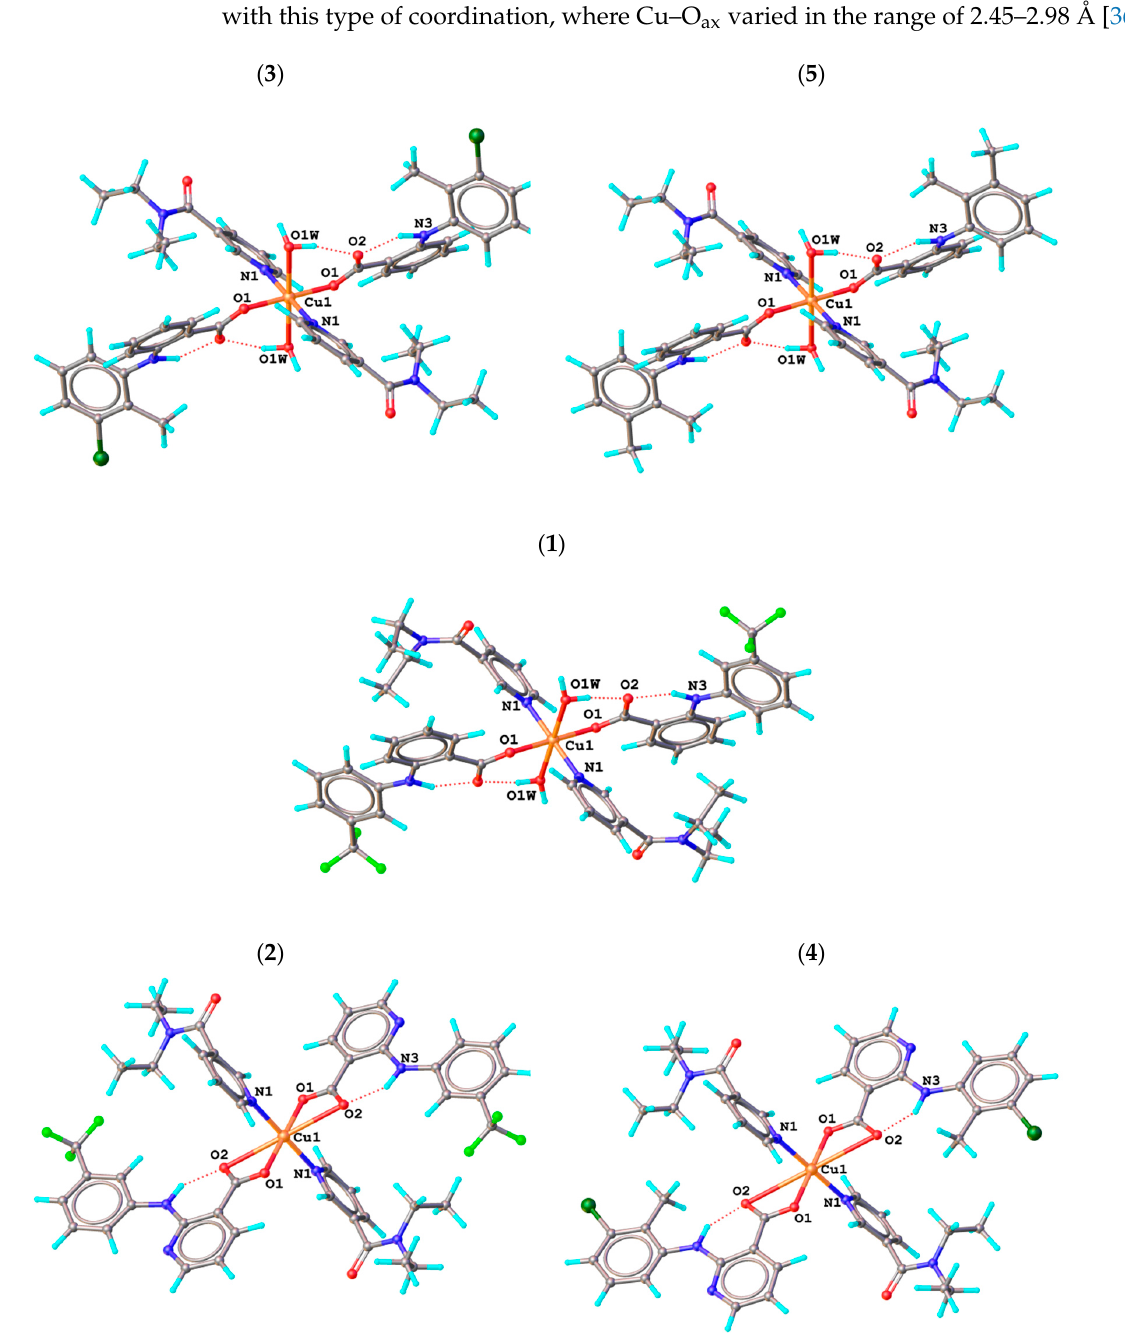
Figure 1. Molecular structures of [Cu(fluf) 2 (dena) 2 (H 2 O) 2 ] ( 1 ), [Cu(nifl) 2 (dena) 2 ] ( 2 ), [Cu(tolf) 2 (dena) 2 (H 2 O) 2 ] ( 3 ), [Cu(clon) 2 (dena) 2 ] ( 4 ) and [Cu(mef) 2 (dena) 2 (H 2 O) 2 ] ( 5 ). The aromatic pyridine (C12–C13–N4–C15–C16–C17) and benzene (C18–C19–C20– C21–C22–C23) rings of the niflumate ( 2 ) or clonixinate ( 4 ) anions are coplanar, which is also supported by intramolecular C–H ∙∙∙ N hydrogen bonds between the carbon atoms of the benzene ring (C23) and the nitrogen atoms of the pyridine ring (N4) (C23–H23 ∙∙∙ N4;